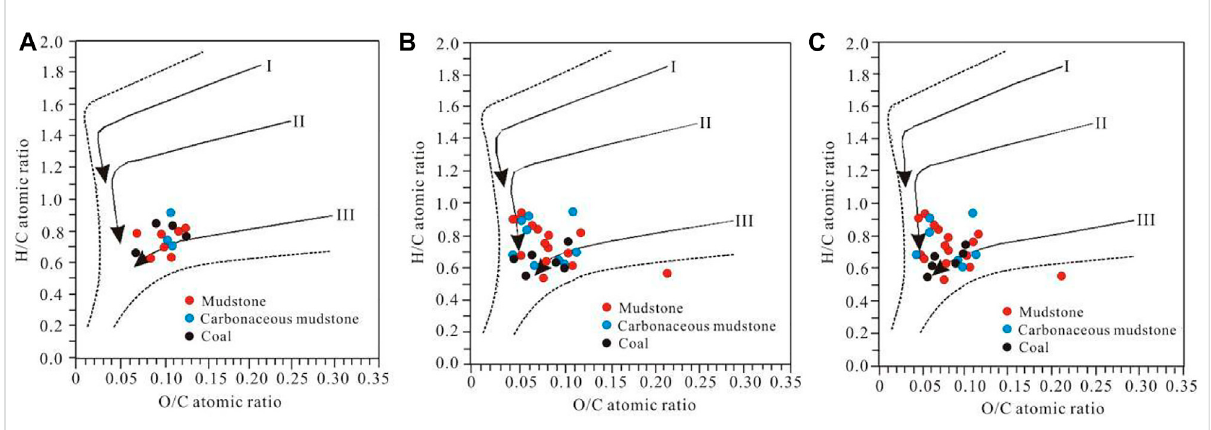
FIGURE 3 Relationship between H/C and O/C atomic ratios of Jurassic source rocks in the study area. Notes: (A) Xishanyao Formation; (B) Sangonghe Formation; (C) Badaowan Formation.